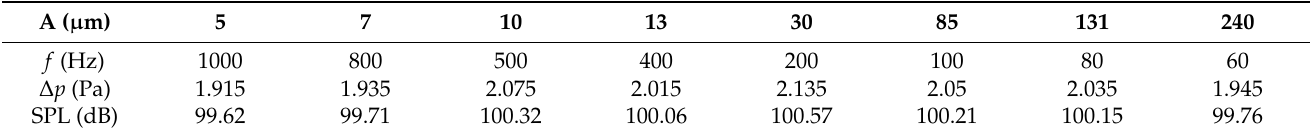
Table 2. Sound frequency and particle size corresponding to the SPL around 100 dB.